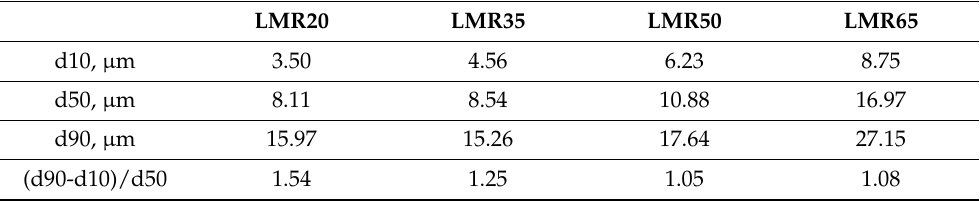
Table 2. The agglomerate size distribution for the Li-rich samples.